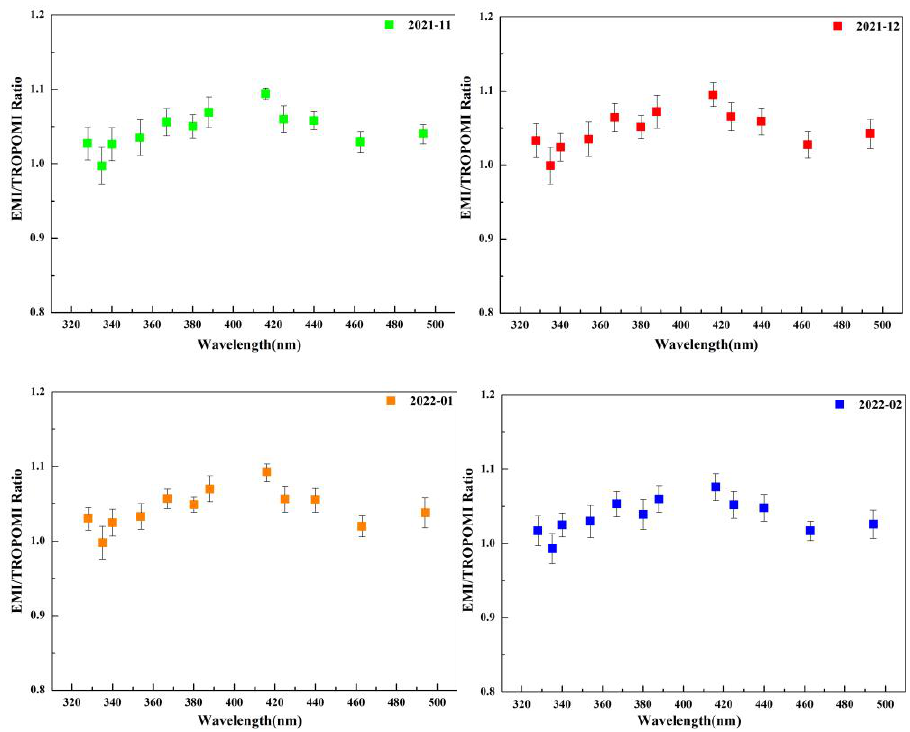
Figure 12. The mean and standard deviation of reflectance ratio between EMI-2 and TROPOMI after spectral adjustment factor and RTM correction.